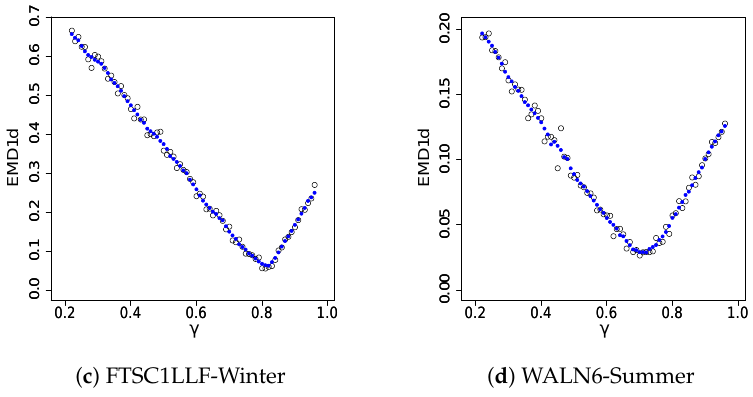
Figure 3. EMD values as a function of γ for.